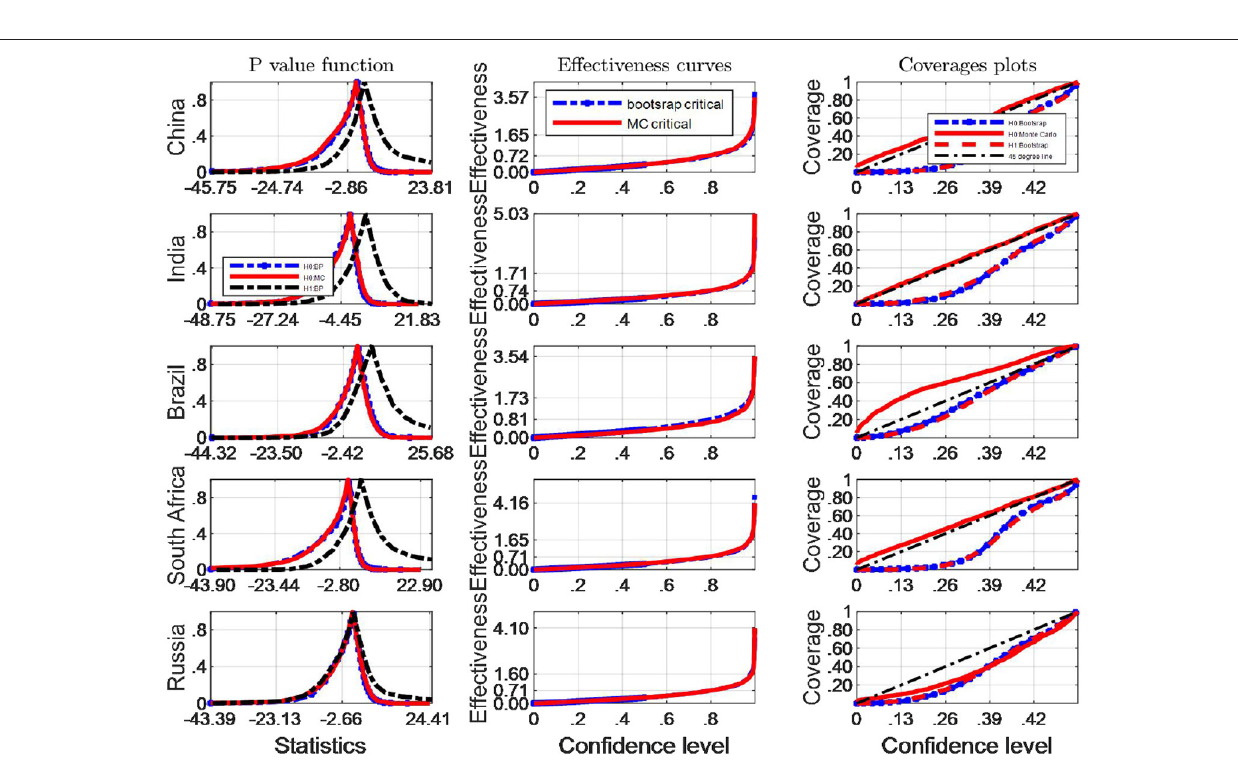
Frontiers in Public Health |